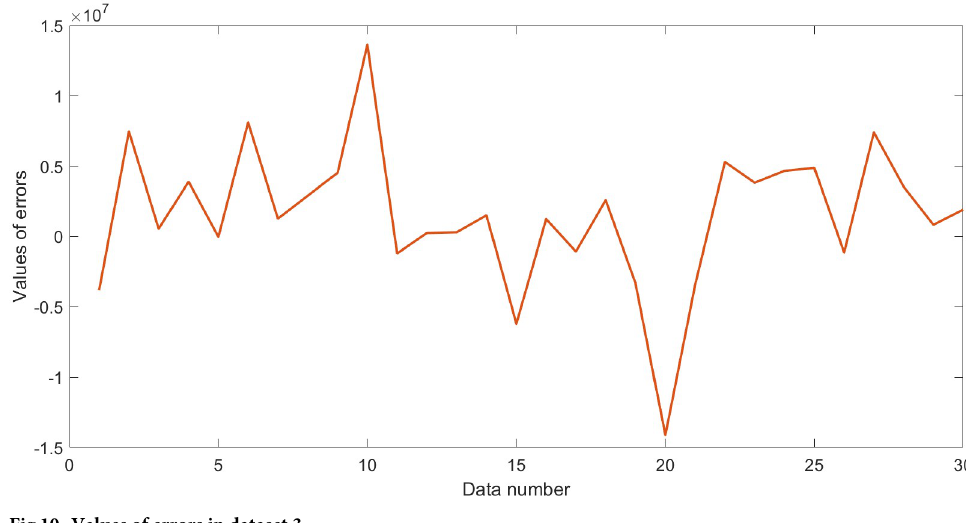
Fig 10. Values of errors in dataset